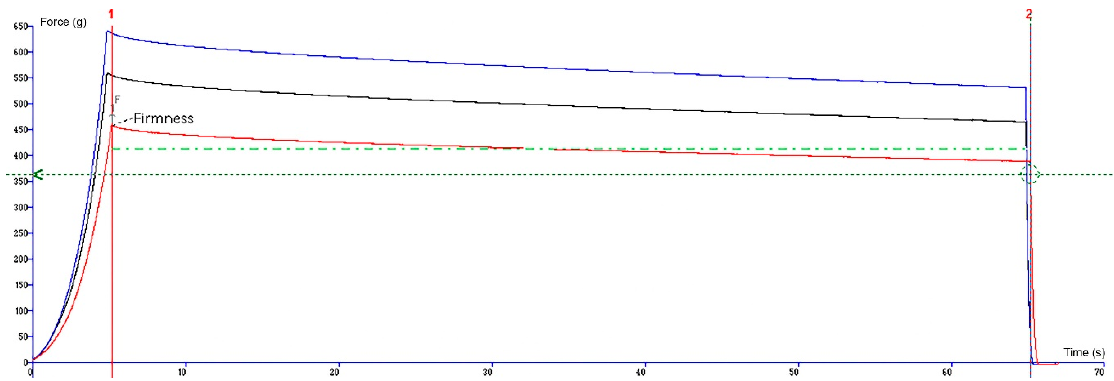
Figure 5. A graphical view of the compression test. The lines represent the three replicates of the sample.